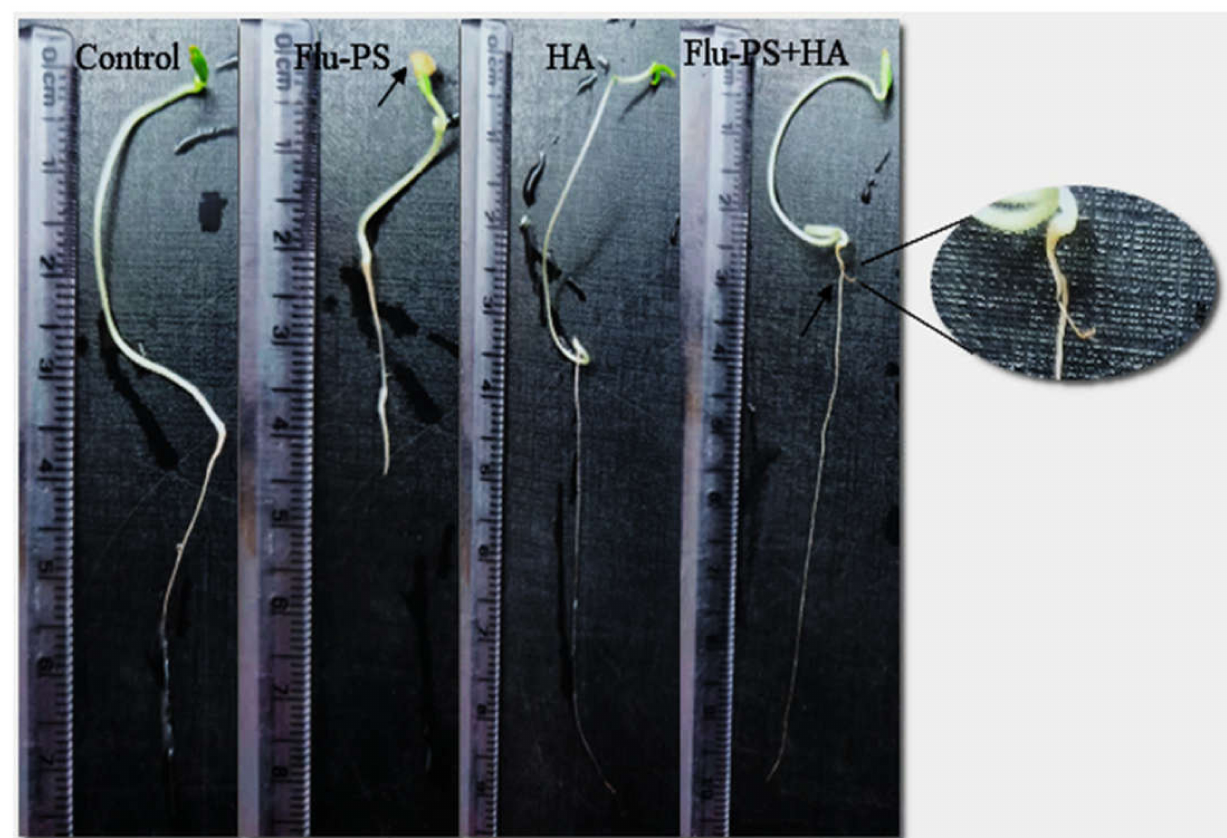
Figure 8. Effect of Flu − PS, HA, and Flu − PS+HA treatments, as well as control (untreated), on Solanum lycopersicum plant over 8 days. Flu − PS shows on the ninth day that the leaf has not been penetrated, while the control and HA showed a full-grown plant. Flu − PS+HA also showed a full-grown plant, followed by secondary root